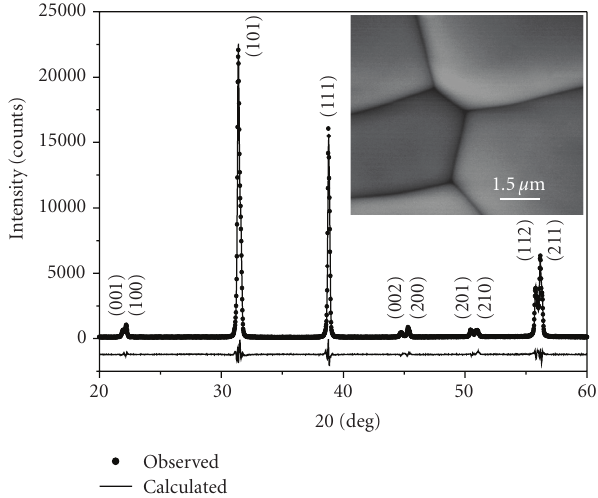
Figure 1: Observed (dots), calculated (continuous line), and di ff erence (bottom line) XRD profiles of PMN-35PT ceramics. Rietveld refinement was performed considering the monoclinic (Pm) and tetragonal (P4mm) phase coexistence model. SEM micrograph of the same ceramics is shown in inset.